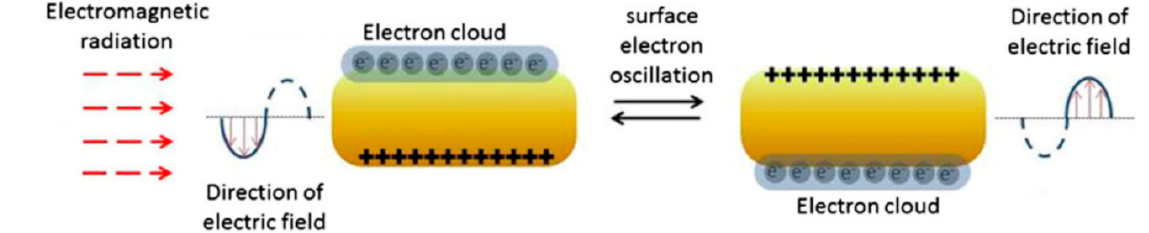
Figure 1. Schematic diagram of the localized surface plasmon resonance due to collective oscillations of conduction electrons at the surface of a gold nanorod in response to laser irradiation. Since the nanorod possesses two axes, a long and a short axis, the oscillations of the electron cloud can happen along both axes. Adapted with permission from [82].